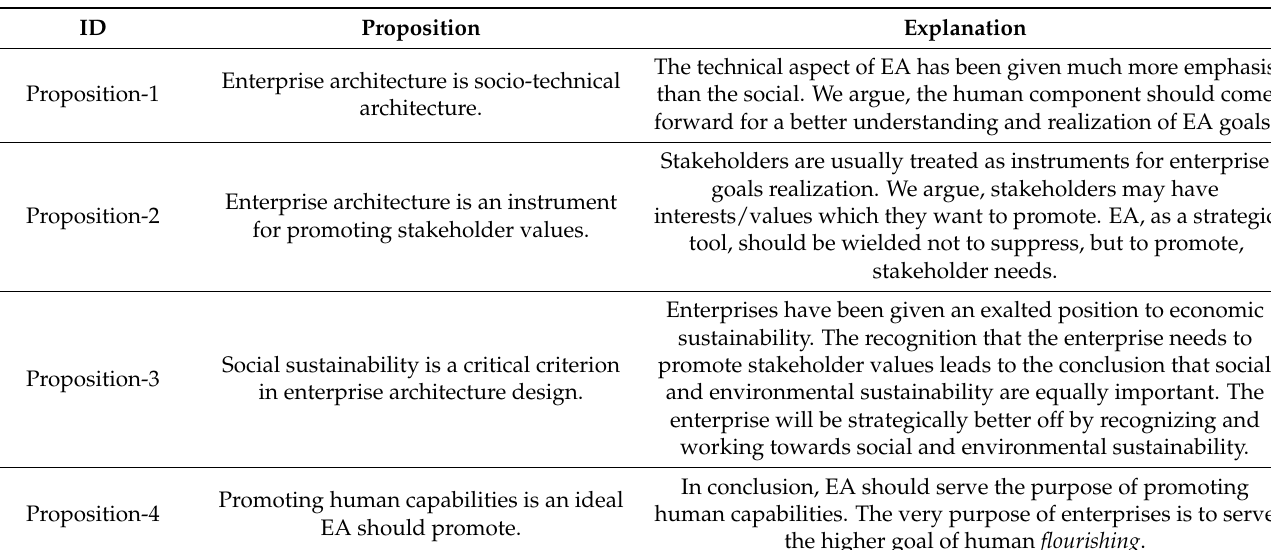
Table 4. Summary of